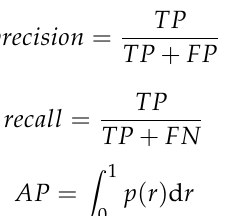
Figure 12. Annotation file.